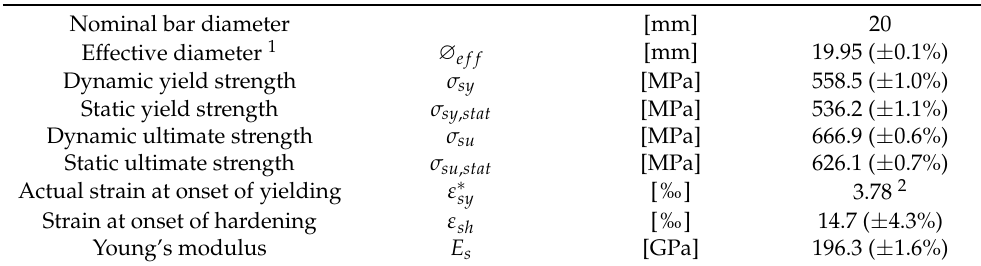
Table 2. Mechanical properties of the reinforcing steel bar used in specimens ERV and ERH, mean values and coefficient of